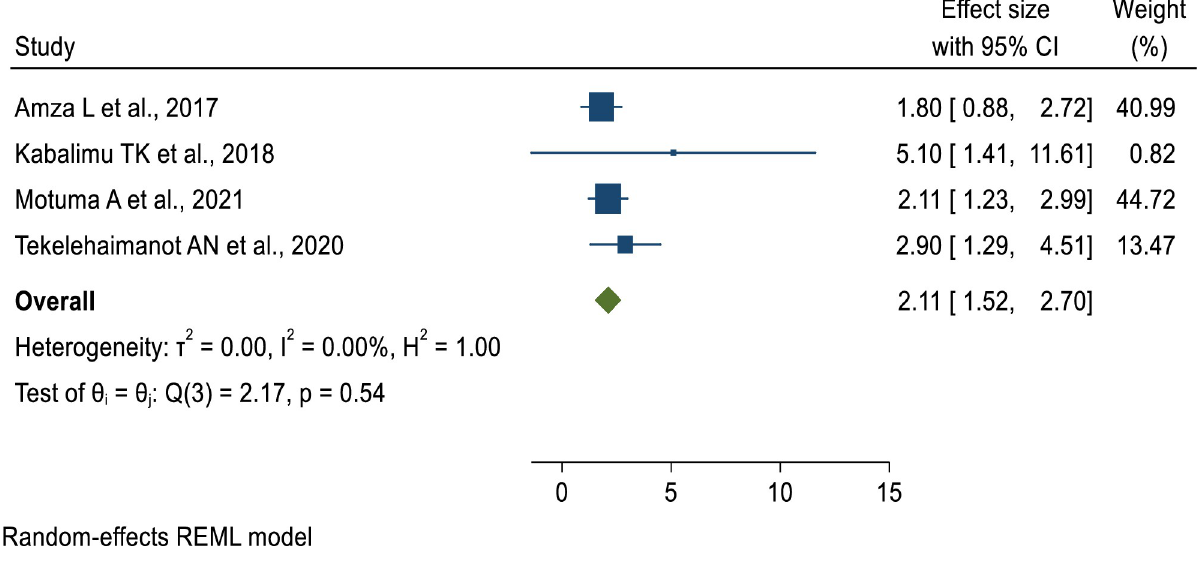
Fig 7. Pooled effect of “sex” on undernutrition among adult PLWHIV in sub-Saharan Africa, 202.